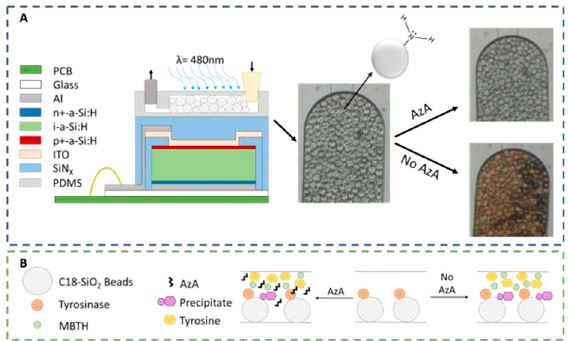
Figure 1. Experimental setup used for the detection of AzA. ( A ) a-Si:H photodiodes (schematic not to scale) are aligned with a PDMS microcolumn packed with APTESfunctionalized SiO 2 beads. The micrographs on the right side of the figure illustrate the optical difference between a contaminated and non-contaminated sample; ( B ) Representation of the reaction mechanism used as a chemical transducer for AzA detection. In a first step, tyrosine is oxidized to a quinone which then reacts with MBTH to produce a colored pigment which is captured by the beads. AzA acts as an enzymatic inhibitor.